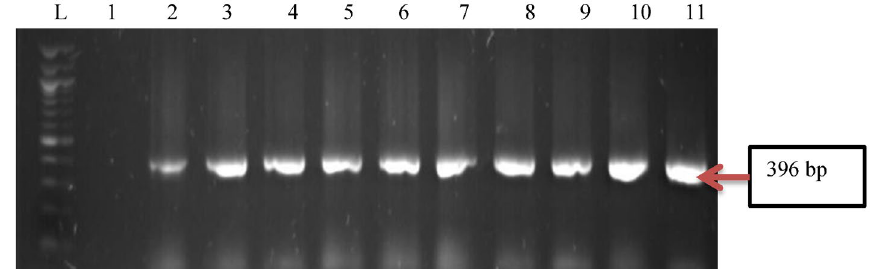
Figure 3. Gel electrophoresis of PCR products of toxA gene among P. aeruginosa representatives isolates recovered from HWW effluent. Lane 1: DNA Marker (100 bp). Lane 1: negative control. Lane 2–11: positive isolates of toxA gene (396 bp).